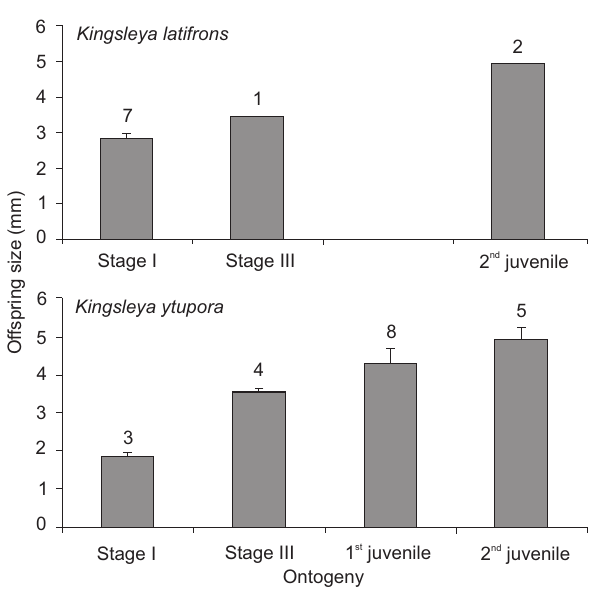
Figure 2. Offspring size (egg length and carapace width of at- tached juveniles) during the early development of the freshwater crabs Kingsleya latifrons (top) and K. ytupora